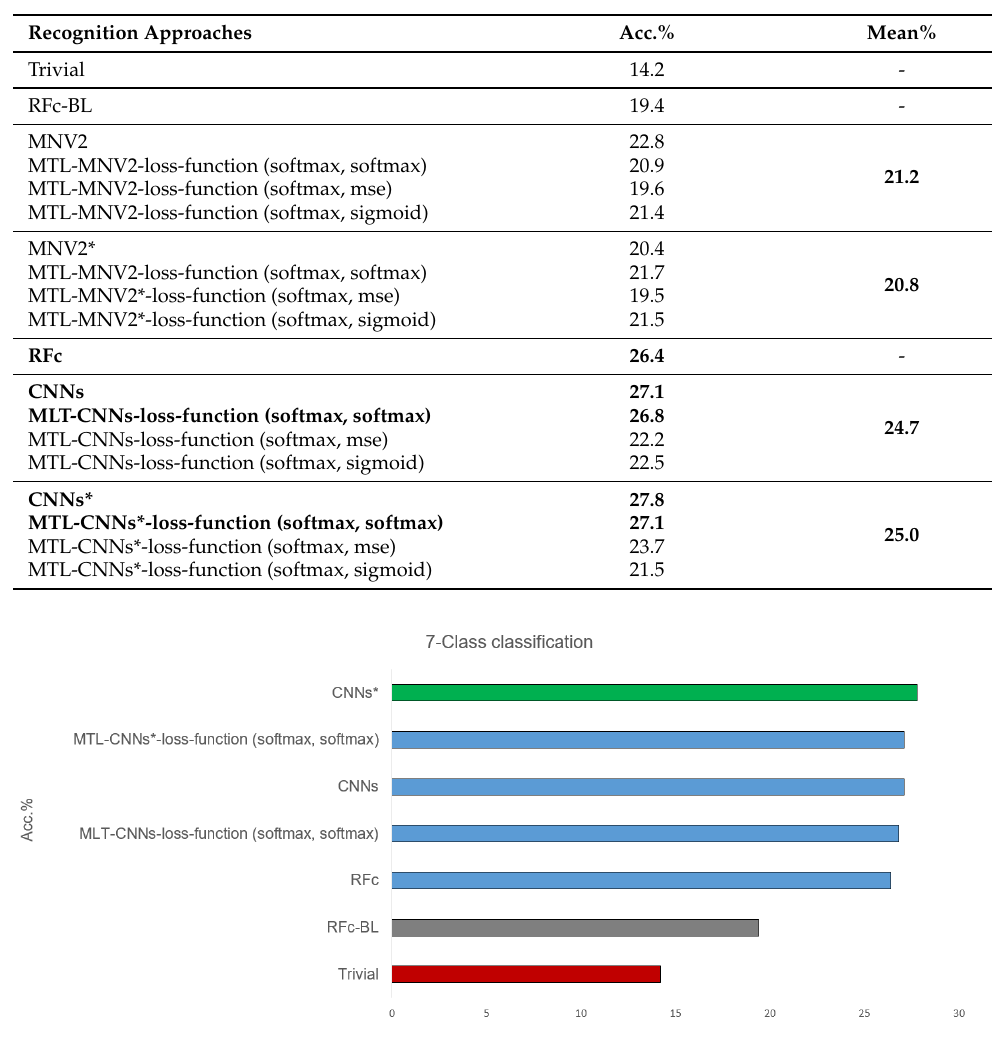
Figure 5. Best recognition models for 7-class classification task compared to baseline and trivial model using all